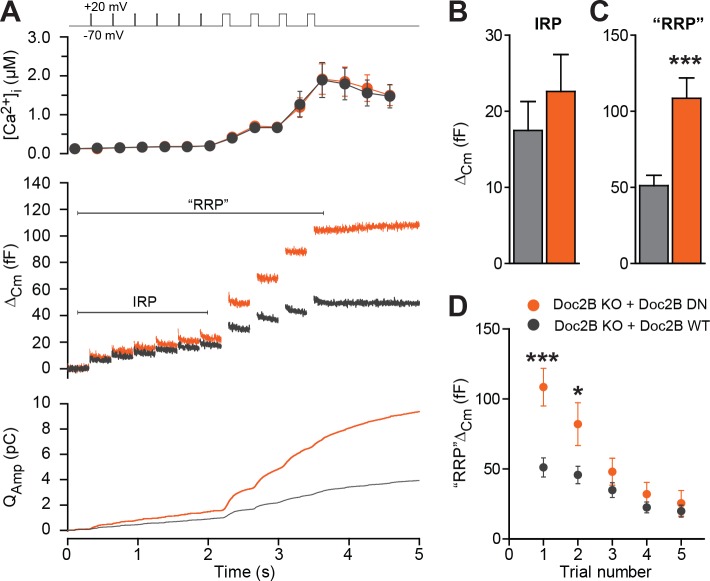
The Doc2B DN-mutant promotes the filling of the Readily Releasable vesicle Pool (RRP), but not the Immediately Releasable Pool (IRP).(A) A depolarization protocol, consisting of 6 brief (10 ms) and four long (100 ms) depolarizations from −70 mV to +20 mV, was repeated a total of 5 times (trials 1–5), separated by 60 s recovery periods. Only the first trial is depicted. A pipette solution with no added calcium and containing 0.5 mM EGTA was used (n = 21 cells for Doc2B WT; n = 22 cells for Doc2B DN). Top panel shows average (±SEM) [Ca2+]i. Middle panel shows the changes in cell membrane capacitance and bottom panel shows the integrated amperometric current (mean traces for all cells). (B) The size of the Immediately Releasable Pool (IRP) was not significantly affected by overexpression of Doc2B DN while (C) the size of the RRP was significantly enhanced by the Doc2B DN mutant, compared to Doc2B WT. (D), Plot of the mean (±SEM) RRP size over the five trials - the responses decrease because of secretory run-down. *p<0.05, ***p<0.001; unpaired, two-tailed Student’s t-test.